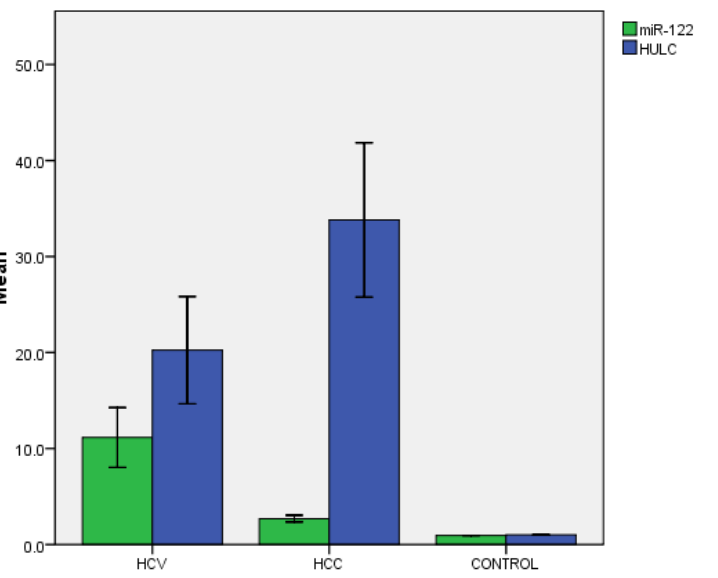
Figure 6. Mean levels of serum biomarkers among studied groups. Mean RQ value of miR-122 in HCV group = 11.16 ± 3.11 and in HCC = 2.69 ± 0.35 with p = 0.004. Mean RQ value of HULC in HCV group = 20.25 ± 5.58 and in HCC = 33.80 ± 8.03 with p = 0.018.